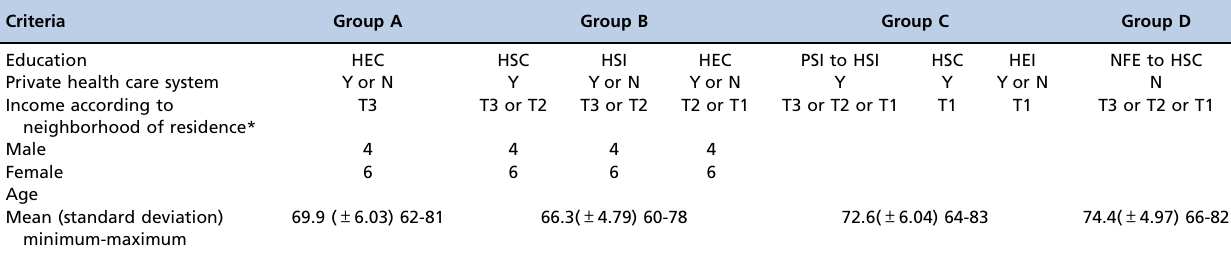
Table 1 - Distribution Criteria of four social groups that were used to evaluate the tool based on the evidence of validity, according to response processes.